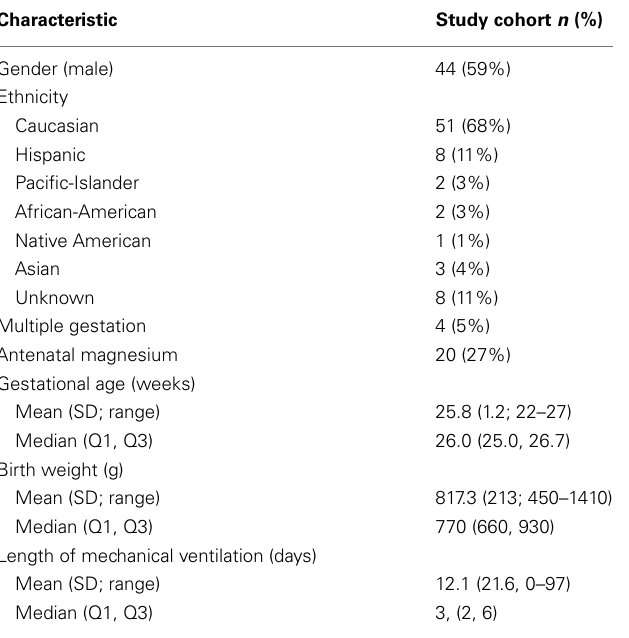
Table 1 | Demographic characteristics of the study group .